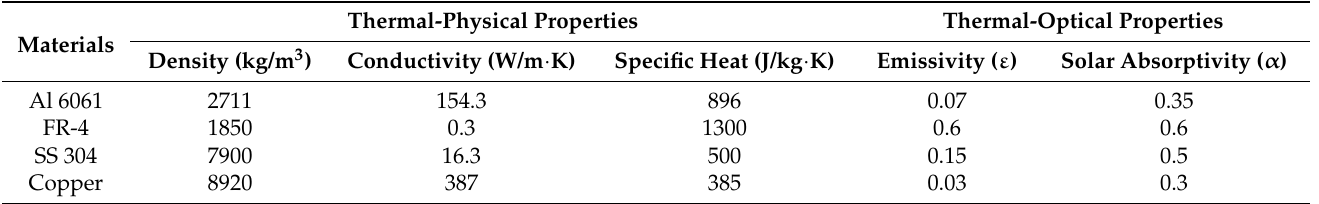
Table 4. Thermal properties of the main CubeSat